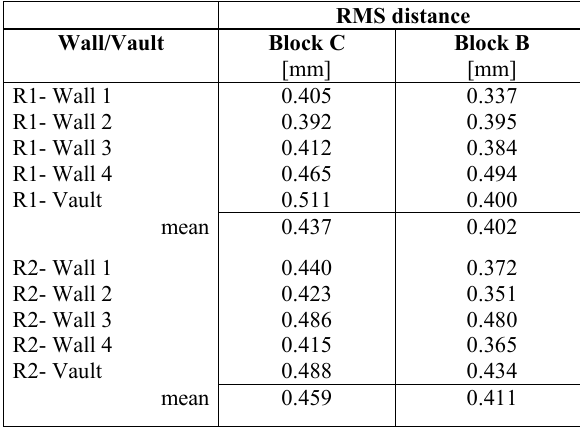
Table 3. Orthophoto comparison.